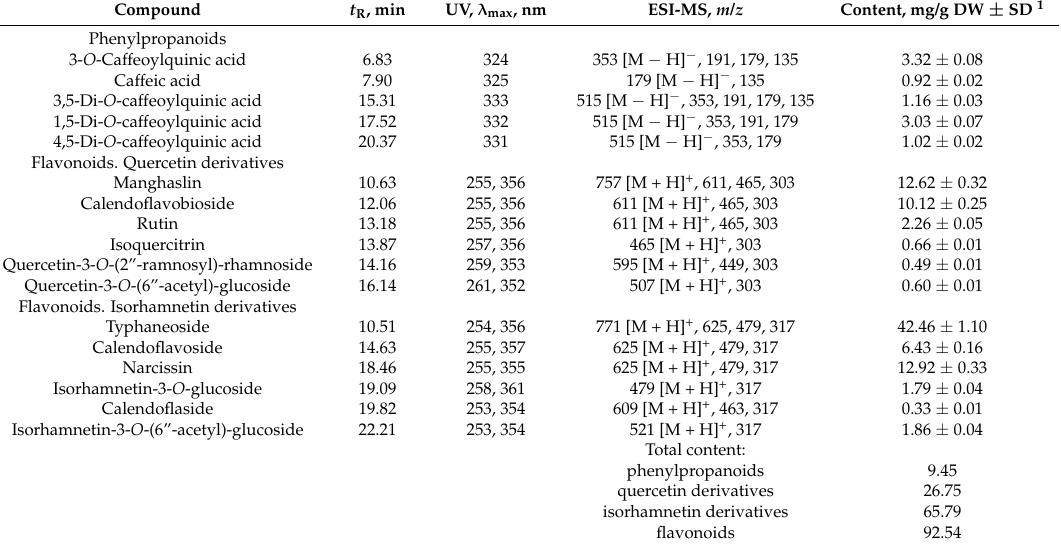
Table 2. HPLC parameters, UV and electrospray ionization mass spectrometry (ESI-MS) data and the content of phenylpropanoids, quercetin and isorhamnetin derivatives in 60% ethanol extract of C. officinalis (Greenheart Orange